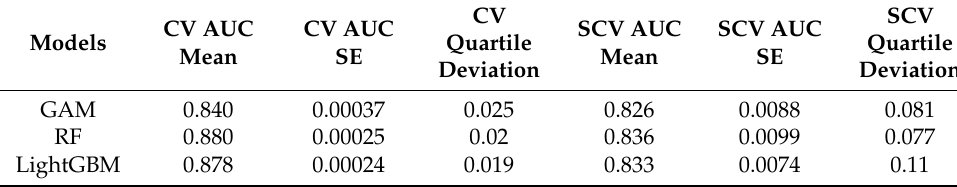
Figure 6. The relative importance of influencing factors by different models. 4.4. Frequency over Empirical Rainfall Threshold Based on the CMIP6 We considered the extreme rainfall scenarios for the CMIP6 for historical period and different future warming scenarios. The observations during historical period were used in order to measure the simulation performance of the CMIP6. In Table 6, the simulated historical rainfall data possessed minimum and maximum values of 1.3 and 12.0, respec- tively, with a mean value of 6.8 and a standard deviation of 2.0. The extreme values and standard deviations of the related FOERT in respect of the simulated historical period were very close to the historical observation data, while the mean was slightly higher. We also calculated the spatial correlation coefficient of 0.58 for both, which was a moderate